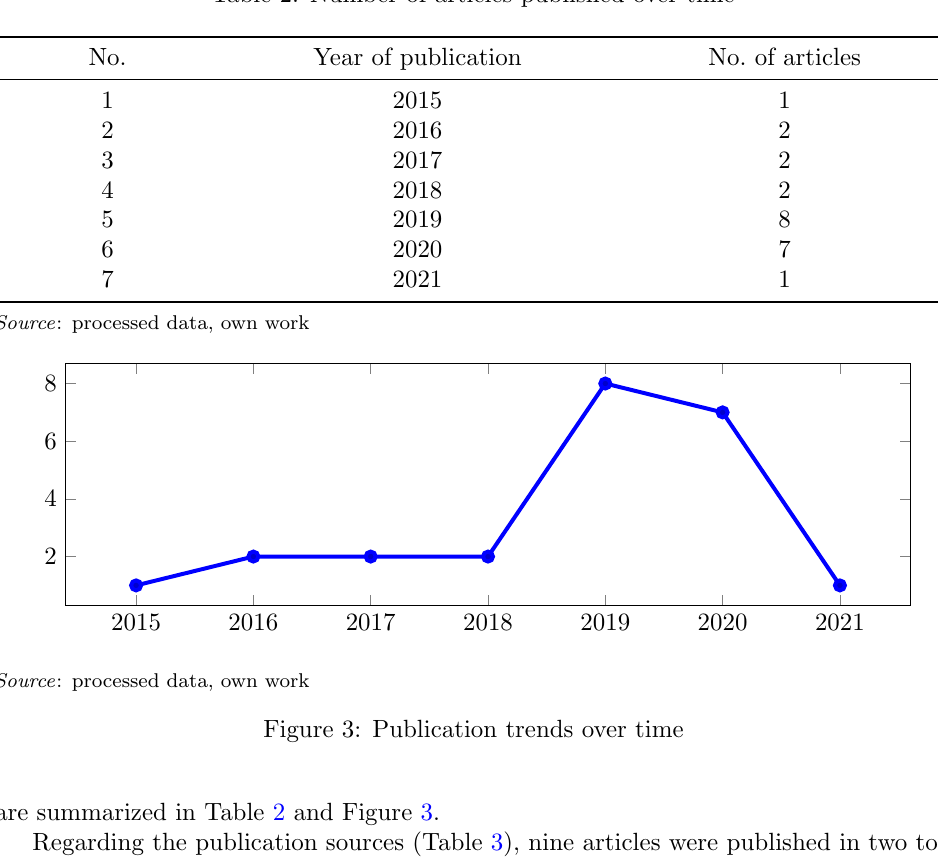
Table 2: Number of articles published over time